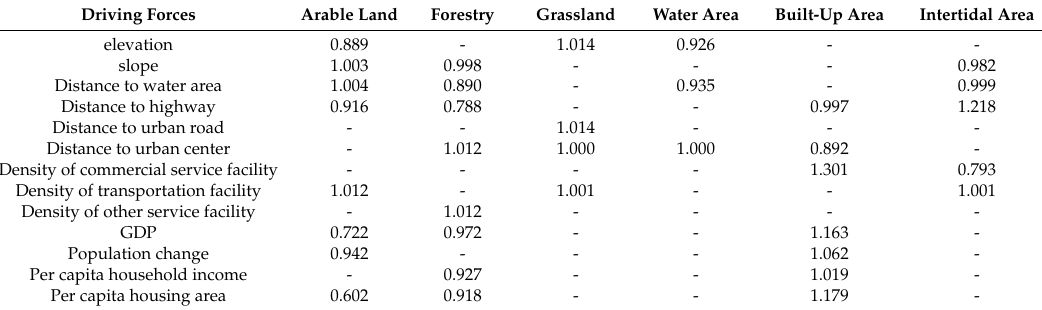
Table 7. Odds ratio of the driving forces of each land use type based on the logistic regression analysis. Driving